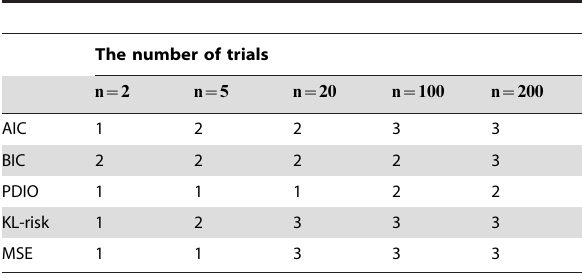
Table 4. Model orders selected by different information criteria for different numbers of trials.